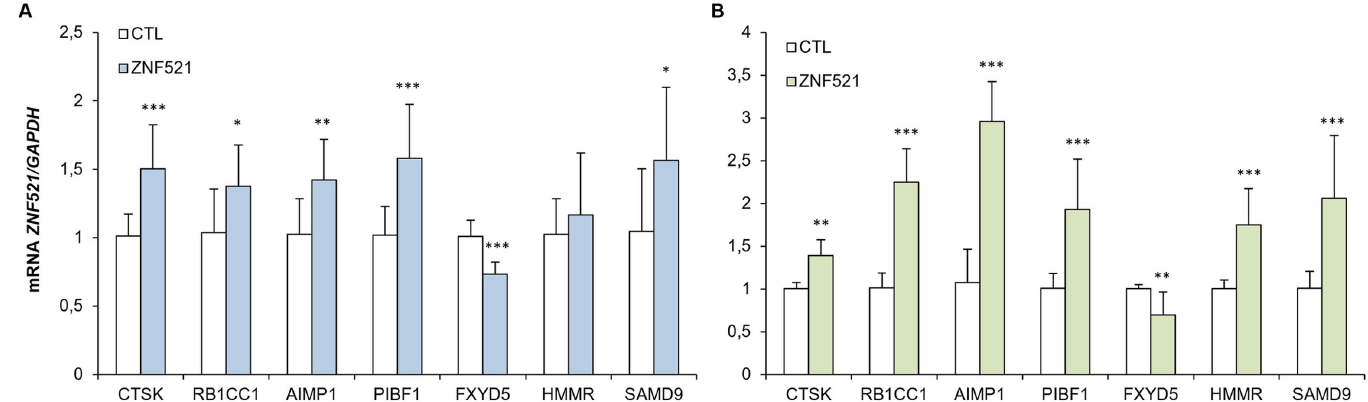
Fig 6. Validation of RNA-Seq data by qRT-PCR: HeyA8 (A), ES-2 (B). The data shown here illustrate the mean of three experiments each conducted in triplicate. Asterisks indicate p < 0,05 � , p < 0,01 �� , p < 0,001 ��� .